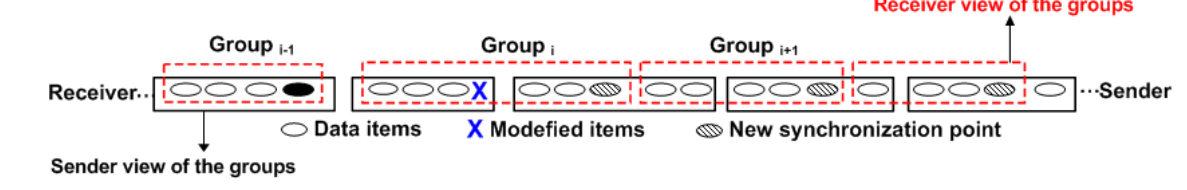
Figure 8. SGW watermarking technique is vulnerable to confusion in forming the groups at the